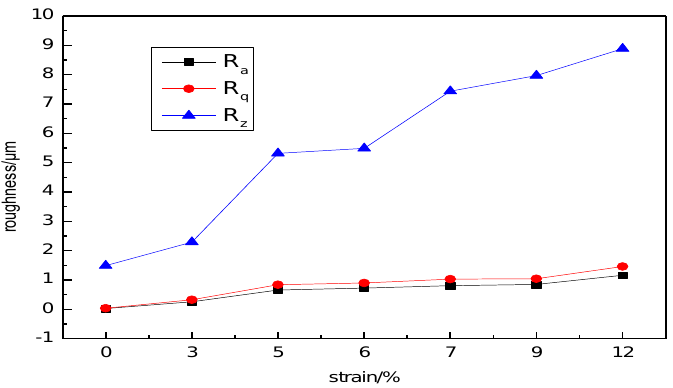
Figure 10. Changing trend of stretched sample surface roughness.